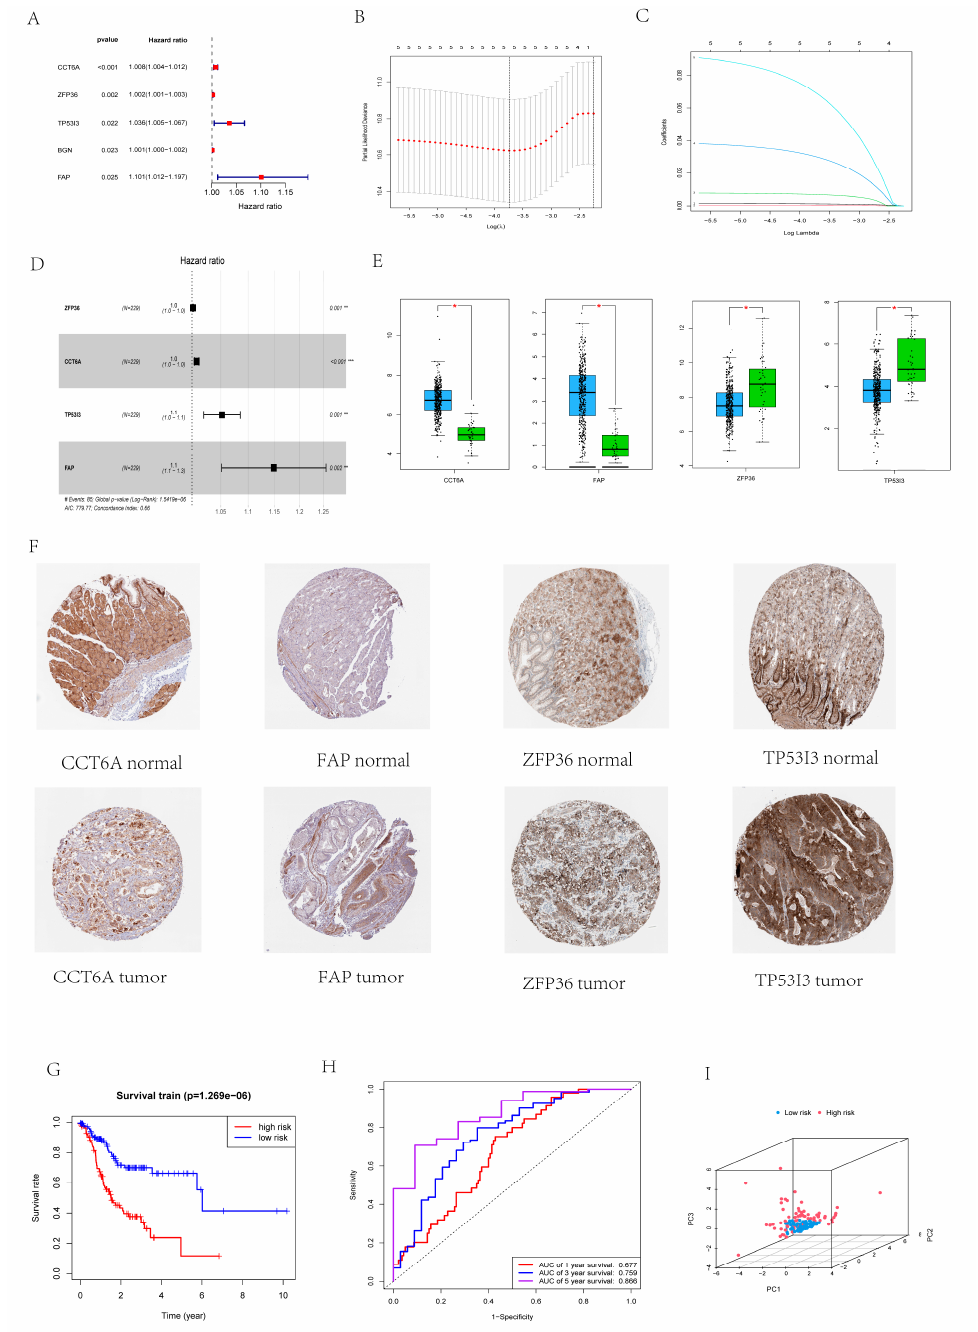
Figure 5. Construction of a necroptosis-related prognostic gene signature . ( A ) Forest map showed 5 necroptosis-related prognostic regulators for GC identified by univariate Cox proportional hazard regression analysis. ( B , C ) The coefficient and partial likelihood deviance of prognostic signature. ( D ) The forest map showed four independent prognostic regulators related to necrotic apoptosis in GC determined by multivariate proportional hazard regression analysis ( E ) Expression of four independent prognostic factors related to necrotic apoptosis in GC (blue represents tumor tissue and green represents normal tissue). ( F ) Expression of four independent prognostic factors related to necrotic apoptosis in HPA. ( G ) OS curve of Train group (red represents high-risk population and blue represents low-risk population). ( H ) ROC curve analysis of Train group. ( I ) PCA analysis of Train group. (* p < 0.05, ** p < 0.01, *** p <